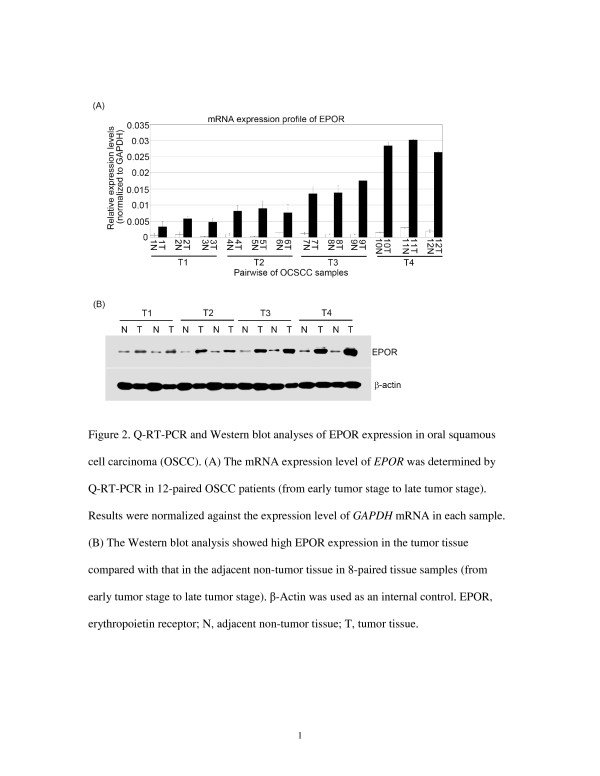
Q-RT-PCR and Western blot analyses of EPOR expression in oral squamous cell carcinoma (OSCC). (A) The mRNA expression level of EPOR was determined by Q-RT-PCR in 12-paired OSCC patients (from early tumor stage to late tumor stage). Results were normalized against the expression level of GAPDH mRNA in each sample. (B) The Western blot analysis showed high EPOR expression in the tumor tissue compared with that in the adjacent non-tumor tissue in 8-paired tissue samples (from early tumor stage to late tumor stage). β-Actin was used as an internal control. EPOR, erythropoietin receptor; N, adjacent non-tumor tissue; T, tumor tissue.